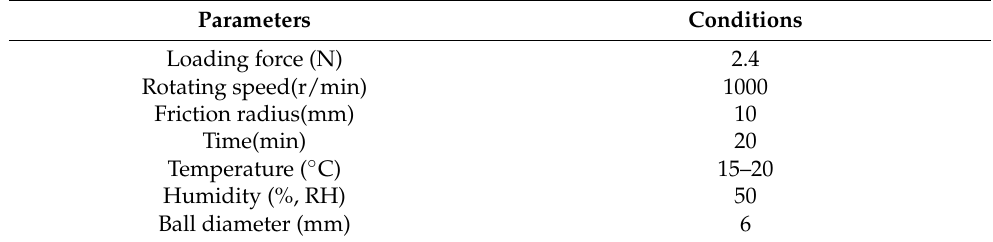
Table 2. Test conditions of the friction